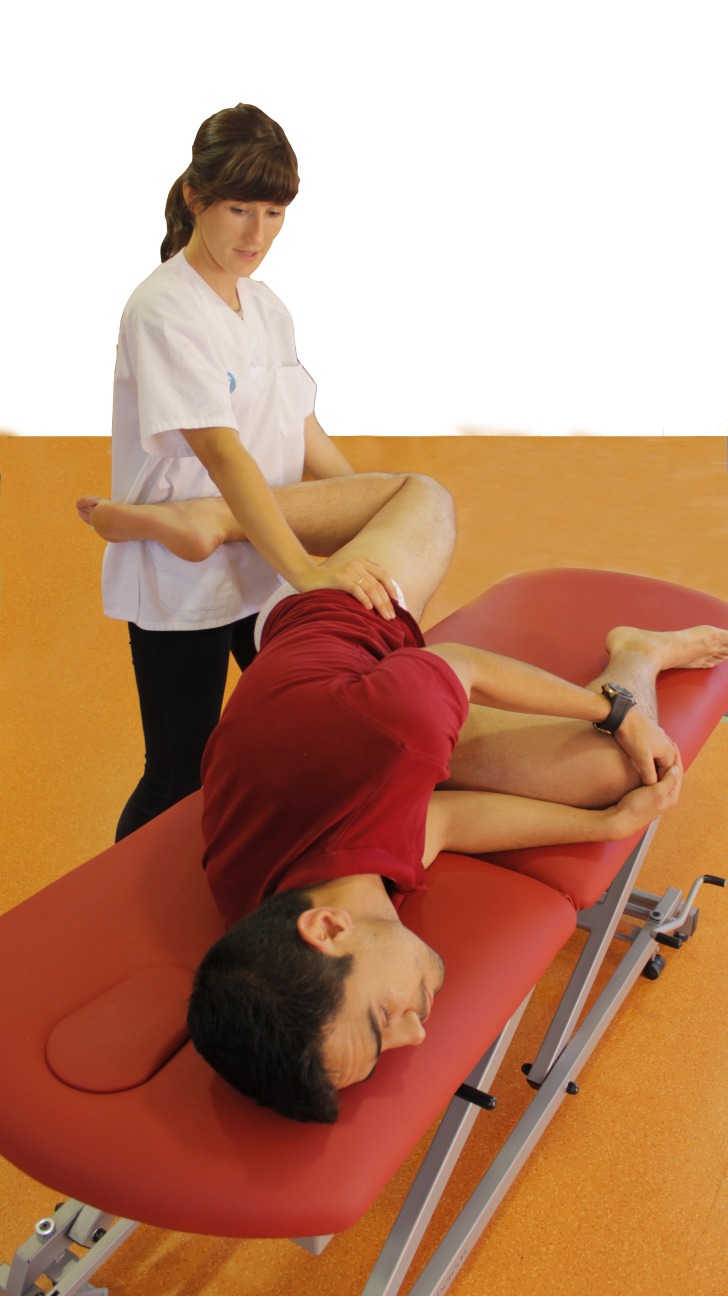
Femoral neurodynamic mobilization.